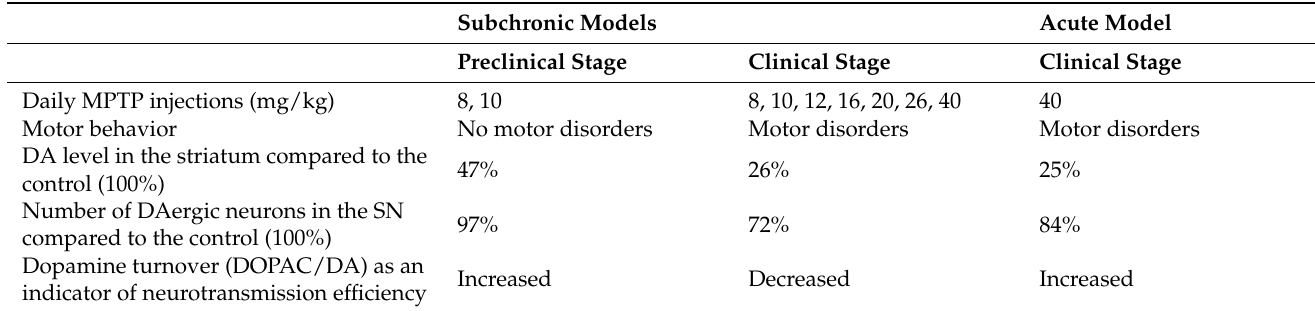
Table 1. The main characteristics of the developed models of Parkinson’s disease: at the preclinical stage and at the clinical stage by daily administration of MPTP in mice at a gradually increasing dose from 8 mg/kg to 10 mg/kg for 2 days and from 8 mg/kg to 40 mg/kg for 7 days, respectively, and at the clinical stage by a single MPTP administration at a dose of 40